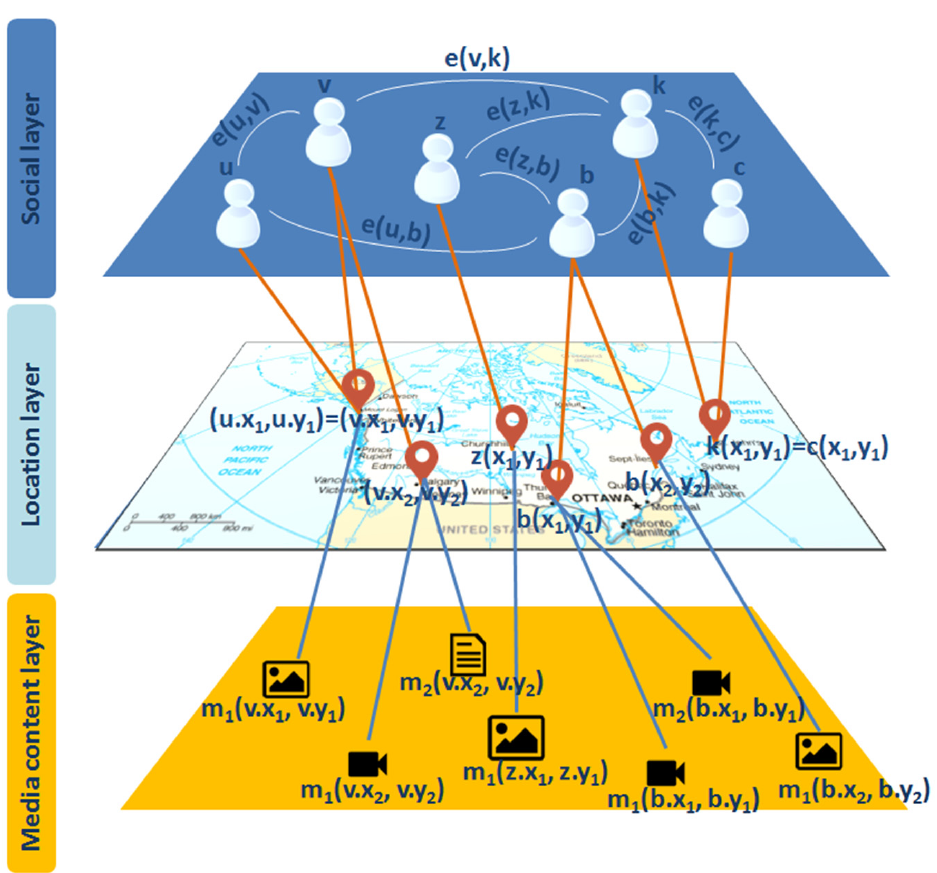
Figure 2. Multilevel geosocial model representing an LBSN with the three layers associated.